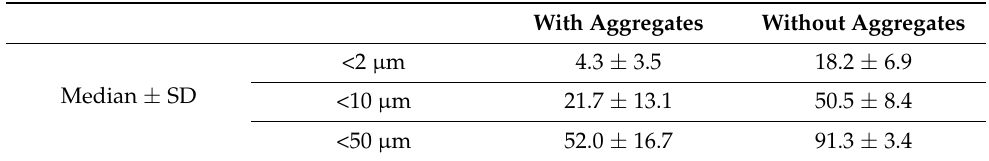
Table 2. LD method. Statistical analysis (median and standard deviation) of PSD of all 156 collected samples